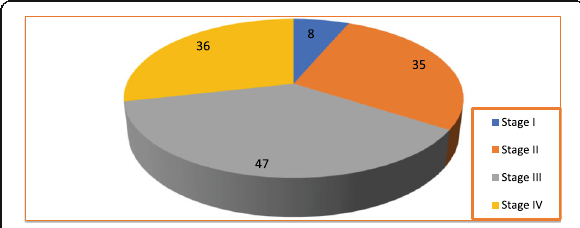
Table 1 Showing association between age and TATE score TATE score